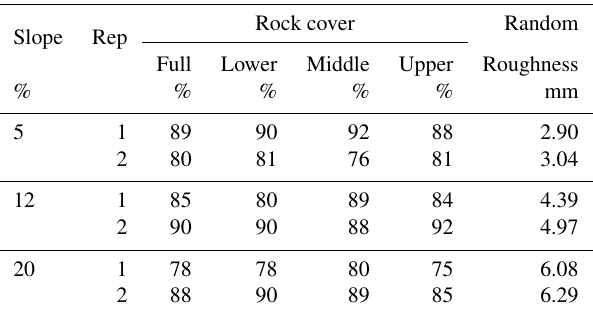
Table 1. Percentages of rock cover greater than 0.5cm for the full, lower, middle, and upper portions of the plots, and laser-measured random roughness measured at the end of each experimental repli- cation.